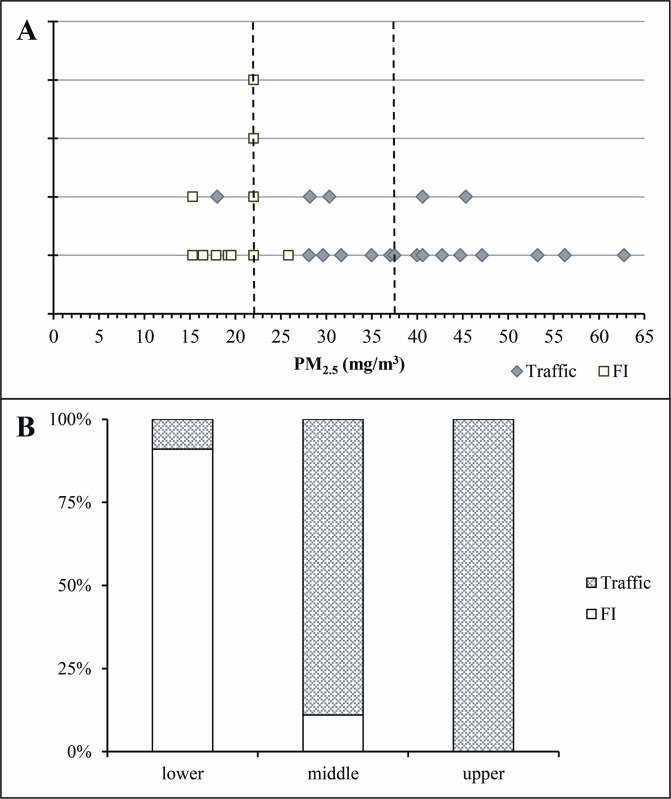
Distribution of subjects in the three categories of PM2.5 levels.(A) Dot-plot of individual PM2.5 levels (μg/m3) of traffic professionals and forest institute staffers (FI). Each data point represents the average of two measurements 15 days apart. PM2.5 levels were defined in the three categories (lower: ≤22 μg/m3; middle: 23–37.5 μg/m3; upper: >37.5 μg/m3). (B) Bar graphs showing the percentage distribution of subjects in the three PM2.5 categories.* p<0.001